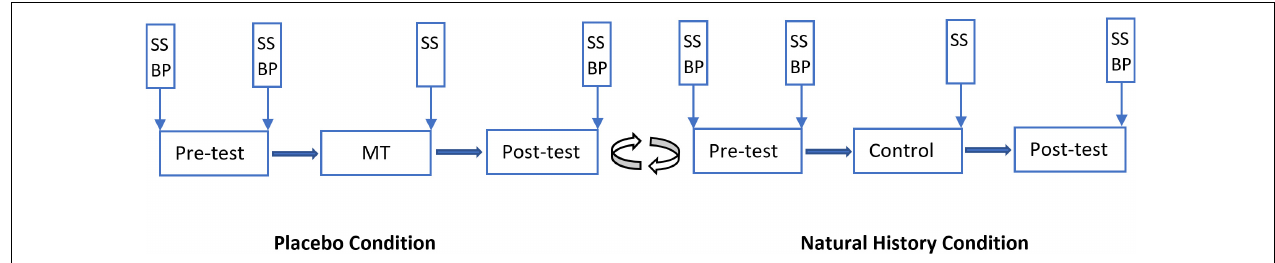
FIGURE 1 | Overview of the Experiment One. Vertical boxes: spots where subjective stress/arousal (SS) and/or blood pressure (BP) were measured. There was a 5-min break between phases and between conditions. MT, manipulation trial. The placebo condition was presented to 29 participants as the first condition, and to 30 participants as the second